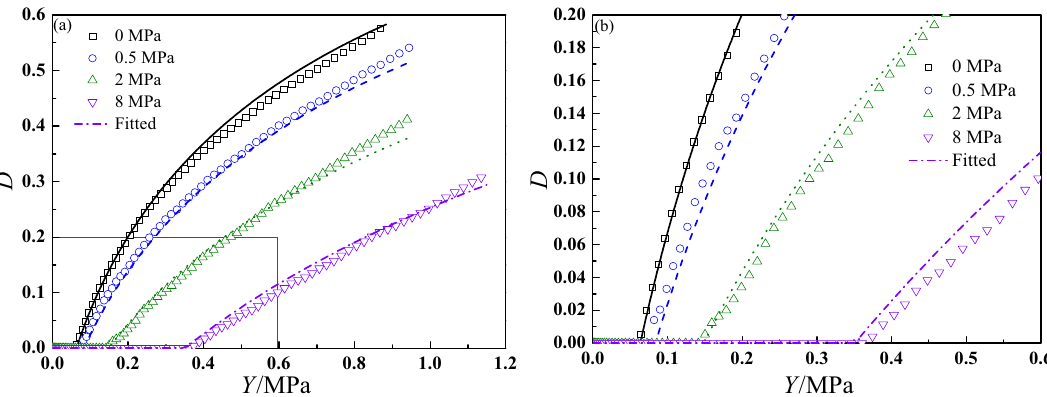
Figure 13. Comparisons of experimental damage evolution curves and fitted curves by Eq. (38) at 1.190 s −1 and various confining pressures.